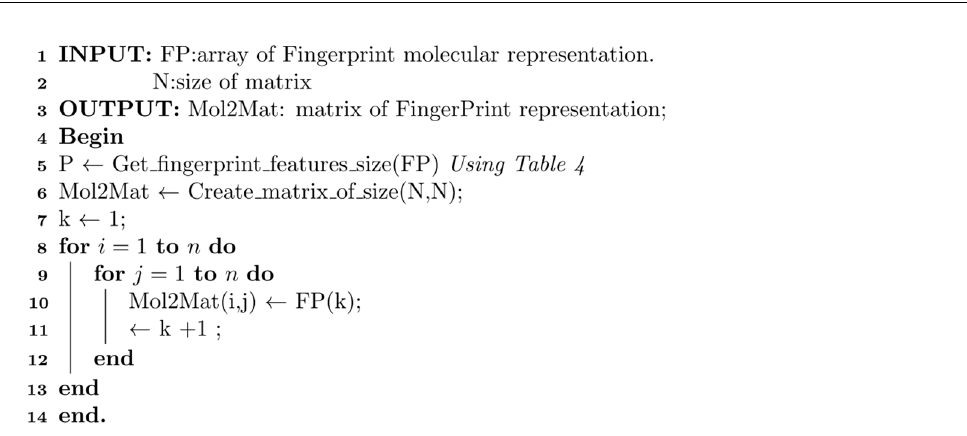
Algorithm 1 : Storing fingerprint in a 2D array